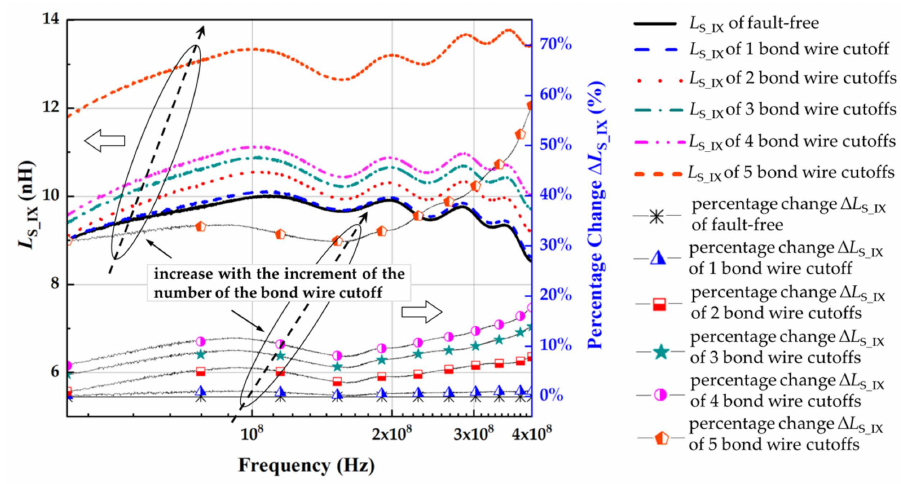
Figure 13. L S_IX of IXFK-32N100P with different cutoff numbers of bond wires.